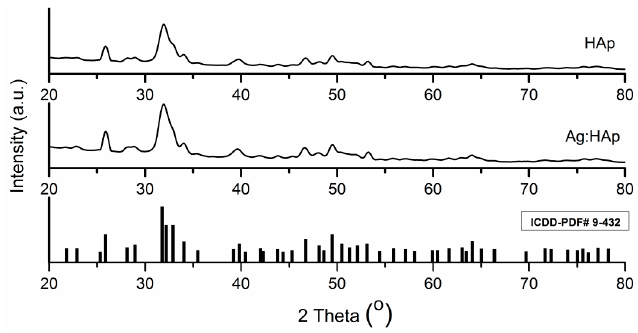
Figure 6. X-ray diffraction patterns of HAp and Ag:HAp thin films.